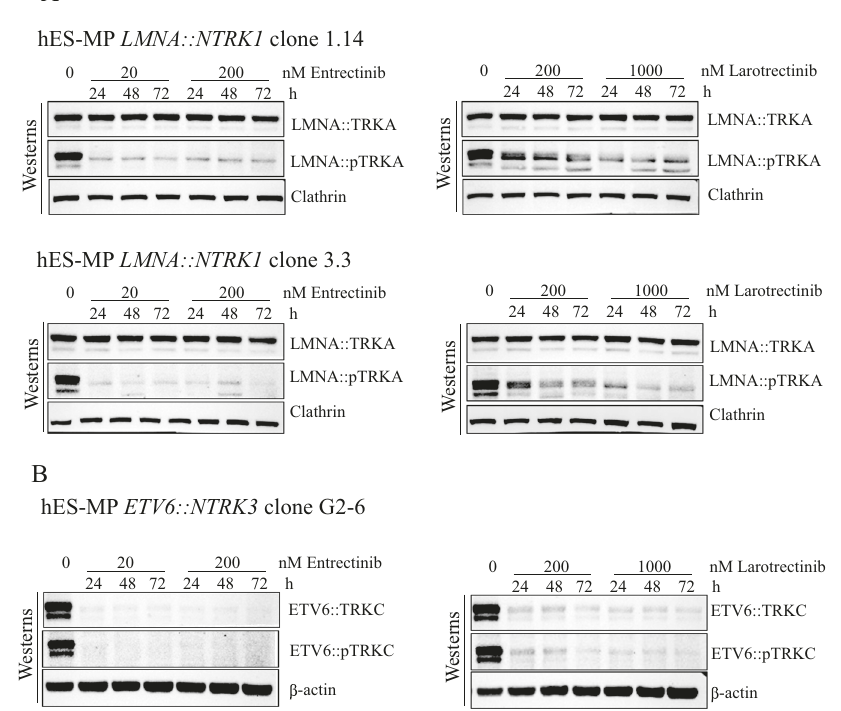
Fig. 4 Response to Entrectinib and Larotrectinib inhibition of hES-MP cells expressing LMNA::TRKA and ETV6::TRKC fusion proteins. A Western blot analysis showing the LMNA-TRKA fusion protein and the loss of TRKA phosphorylation in hES-MP clones 1.14 and 3.3 after 24, 48, and 72 h treatment with the TRK inhibitors Entrectinib (0, 20, and 200 nM) and Larotrectinib (0, 200, and 1000 nM). B Reduced ETV6::TRKC protein stability and TRKC phosphorylation in hES-MP clone G2-6 at different doses of Entrectinib and